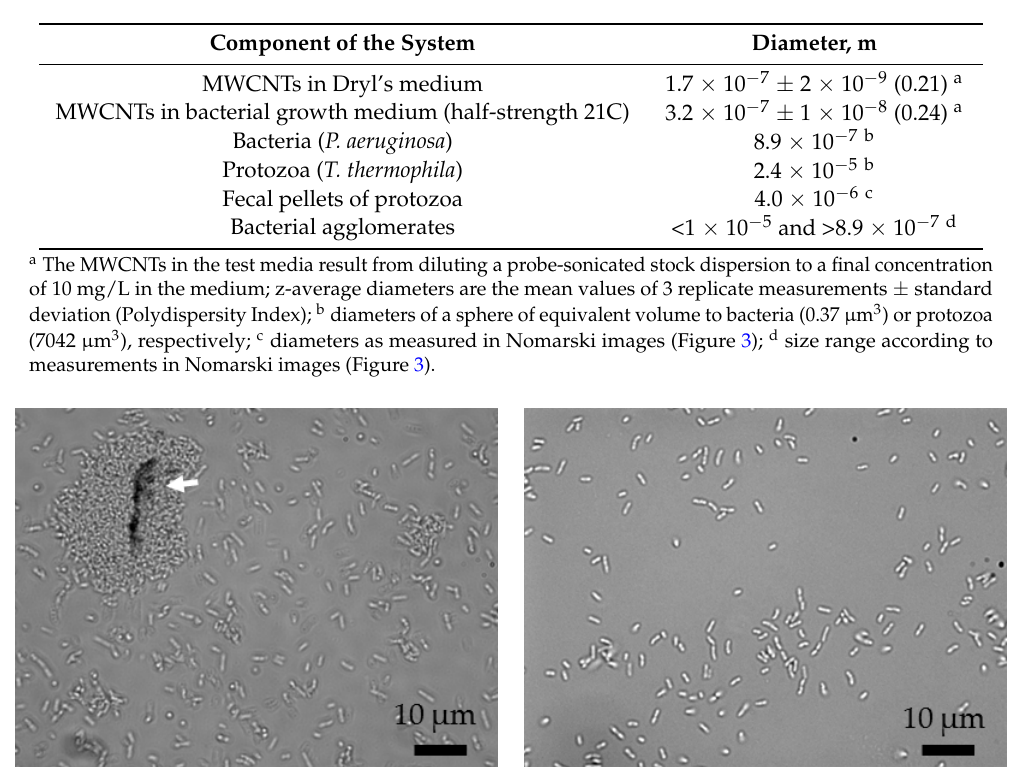
Table 1. Hydrodynamic diameters of MWCNTs in test media, diameters of bacteria in half ‐ strength 21C medium and diameters of protozoa and other components of the system in Dryl’s medium.